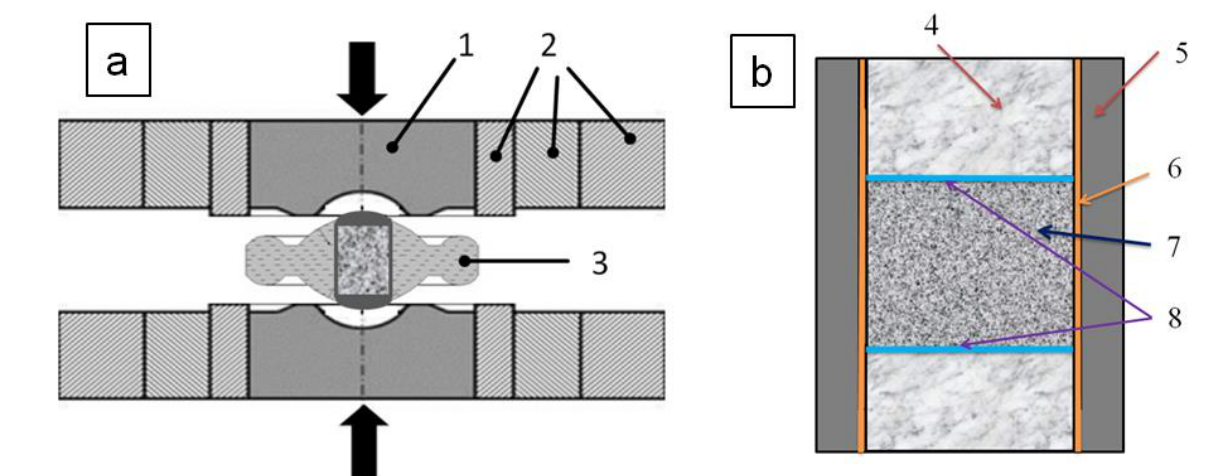
Figure 1. “Toroid” type high-pressure chamber. ( a ) Chamber assembly scheme: 1—hard alloy punch, 2—steel rings, and 3—limestone container; ( b ) High pressure cell: 4—a tablet made from mixture of graphite and boron nitride, 5—graphite heater, 6—Ta-foil, 7—a mixture of diamond powders, and 8 — Ni-foil.